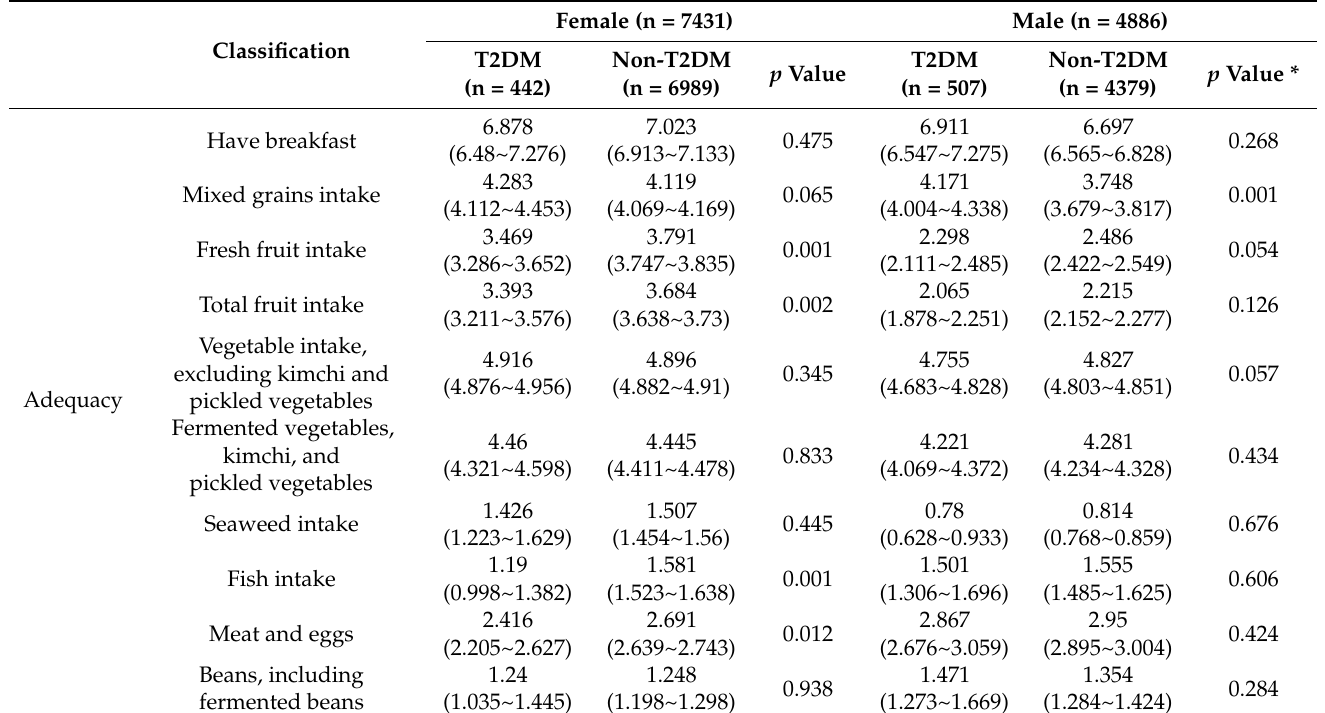
Table 3. Adjusted means ¶ and 95% CI of KHEI score according to genders and diabetes after adjustments for